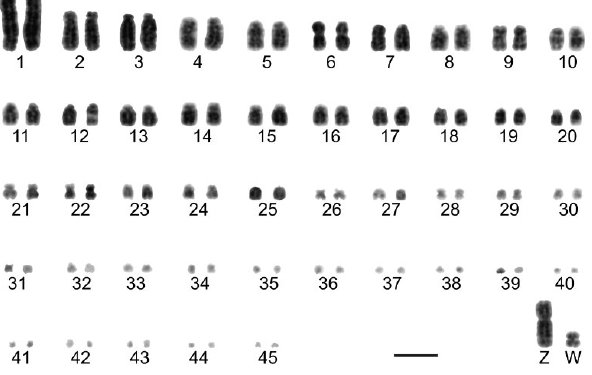
Figure 1. Conventionally stained complete karyotypes of Calidris canutus with 2n = 92. Bar 5 μ m.